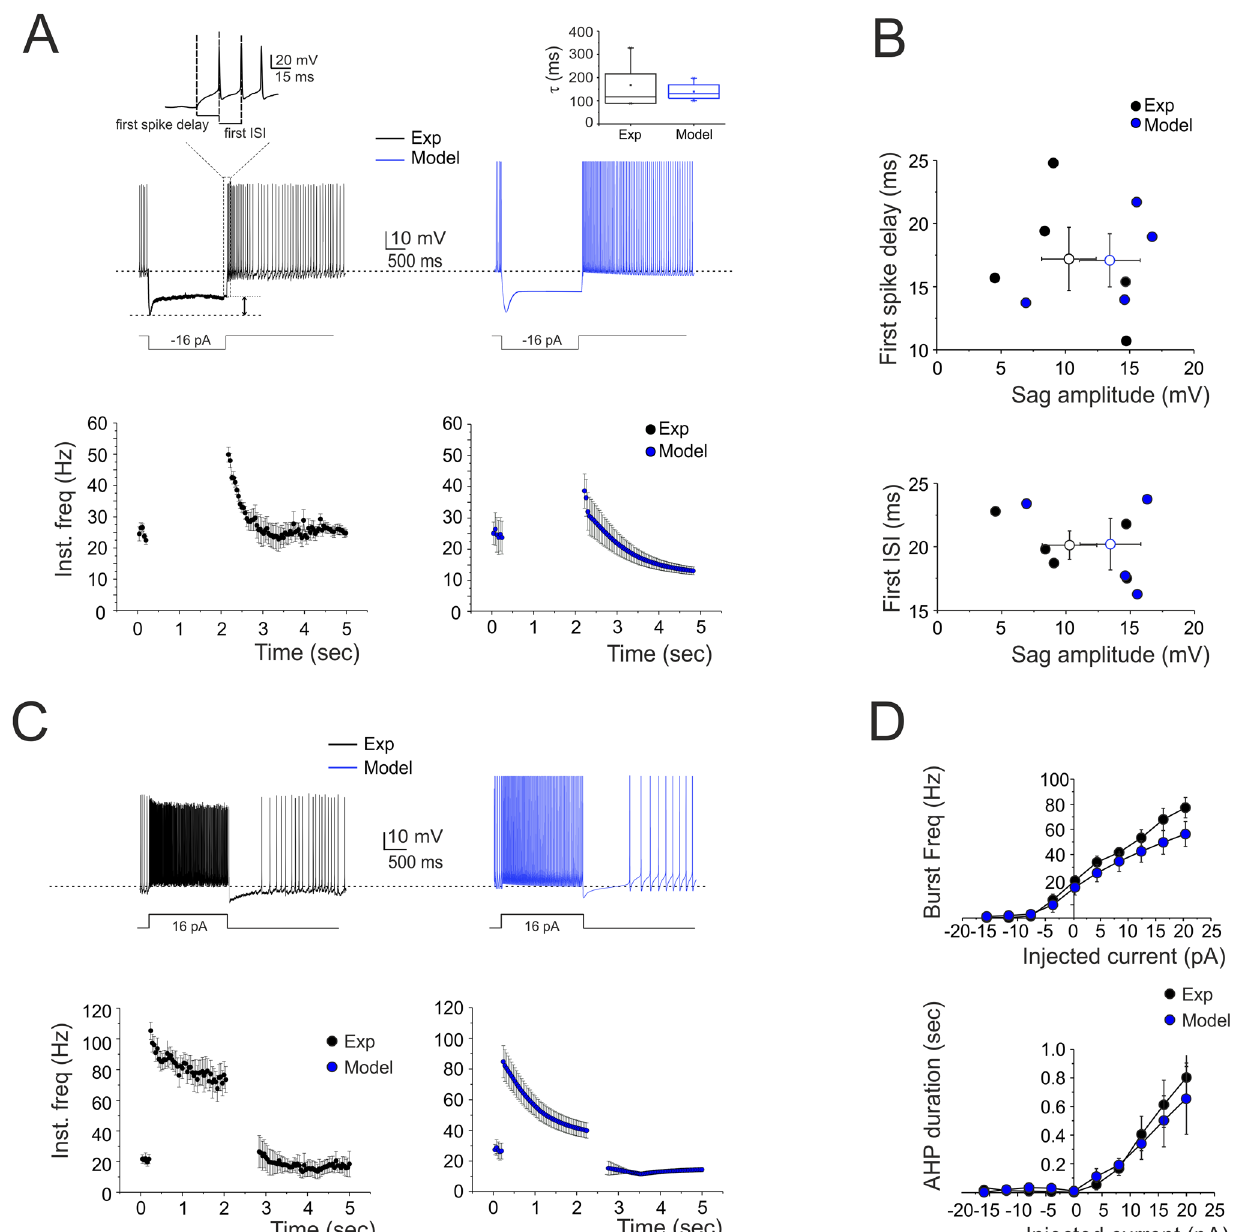
Figure 3. Response to hyperpolarization and depolarization. (A) A WCR from a SC shows sagging inward rectification in response to hyperpolarizing current injection and, at the end of the hyperpolarization, rebound excitation with an early and a protracted phase of intensified firing. Simulations of this specific experiment show that the model could faithfully reproduce sagging inward rectification and rebound excitation (blue trace). The enlarged trace on top shows how the first spike delay and the first ISI were determined. At the bottom, the time course of instantaneous spike frequency for a − 16 pA current pulse. The box-and-whisker plot compares the sag decay time constant obtained in experiments (n = 6) and simulations (n = 4) without revealing statistically significant difference (unpaired t -test, p = 0.4) (B) The plots report the time to first spike and the first ISI during rebound excitation as a function of sag amplitude (black circles; n = 5). Note that the model (blue circles; n = 4) did not significantly differ from the experimental data (p = 0.32). Data are reported as mean ± SEM. (C) A WCR from a SC shows the firing frequency and the pause following depolarizing current step (16 pA). The time course of instantaneous spike frequency for the 16-pA current pulse is shown below. Simulations show that the model could faithfully reproduce this behavior (blue traces). (D) In the plots, the response of the model (blue circles; n = 4) to current injections (from -16 to 20 pA) is compared to experimental data (black circles; n = 5). Simulations show that the model could appropriately fit the experimental measurements of spike frequency versus injected current (16 pA: p = 0.097) and of pause versus injected current (16 pA: p = 0.69). Data are reported as mean ±